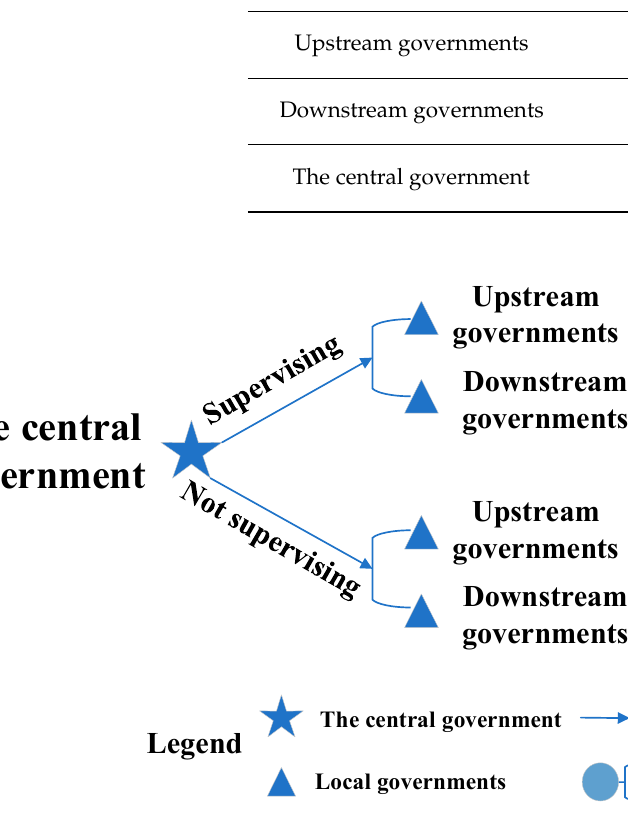
Figure 3. Decision tree of interested parties.